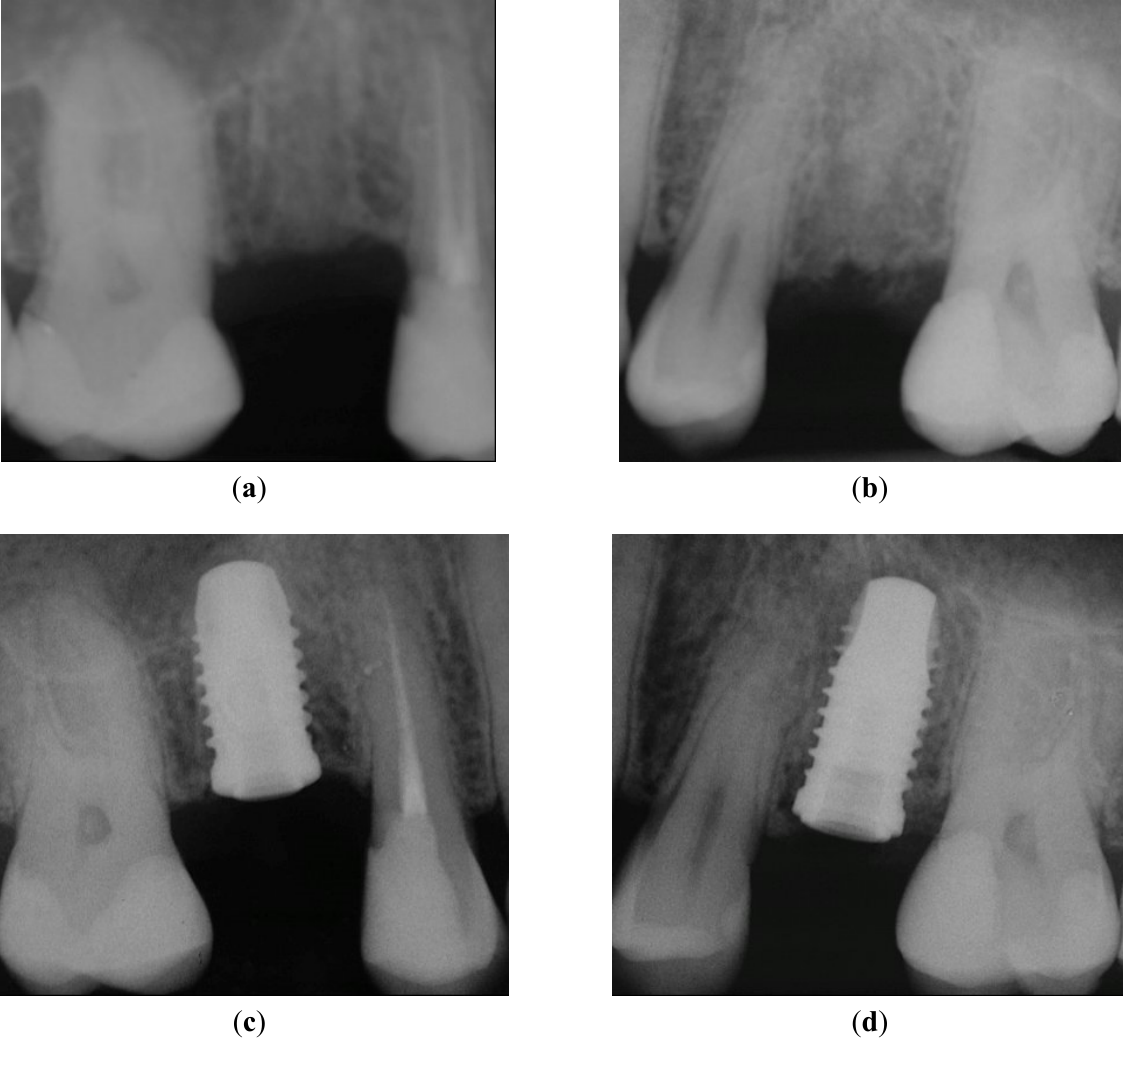
Figure 4. X-rays taken before implant insertion and immediately after implant placement: ( a ) healed crestal bone in Position 15; ( b ) healed crestal bone in Position 25. No pathological signs were present after implant placement of both implants: ( c ) Position 15, implant with PFS; ( d ) Position 25, StE